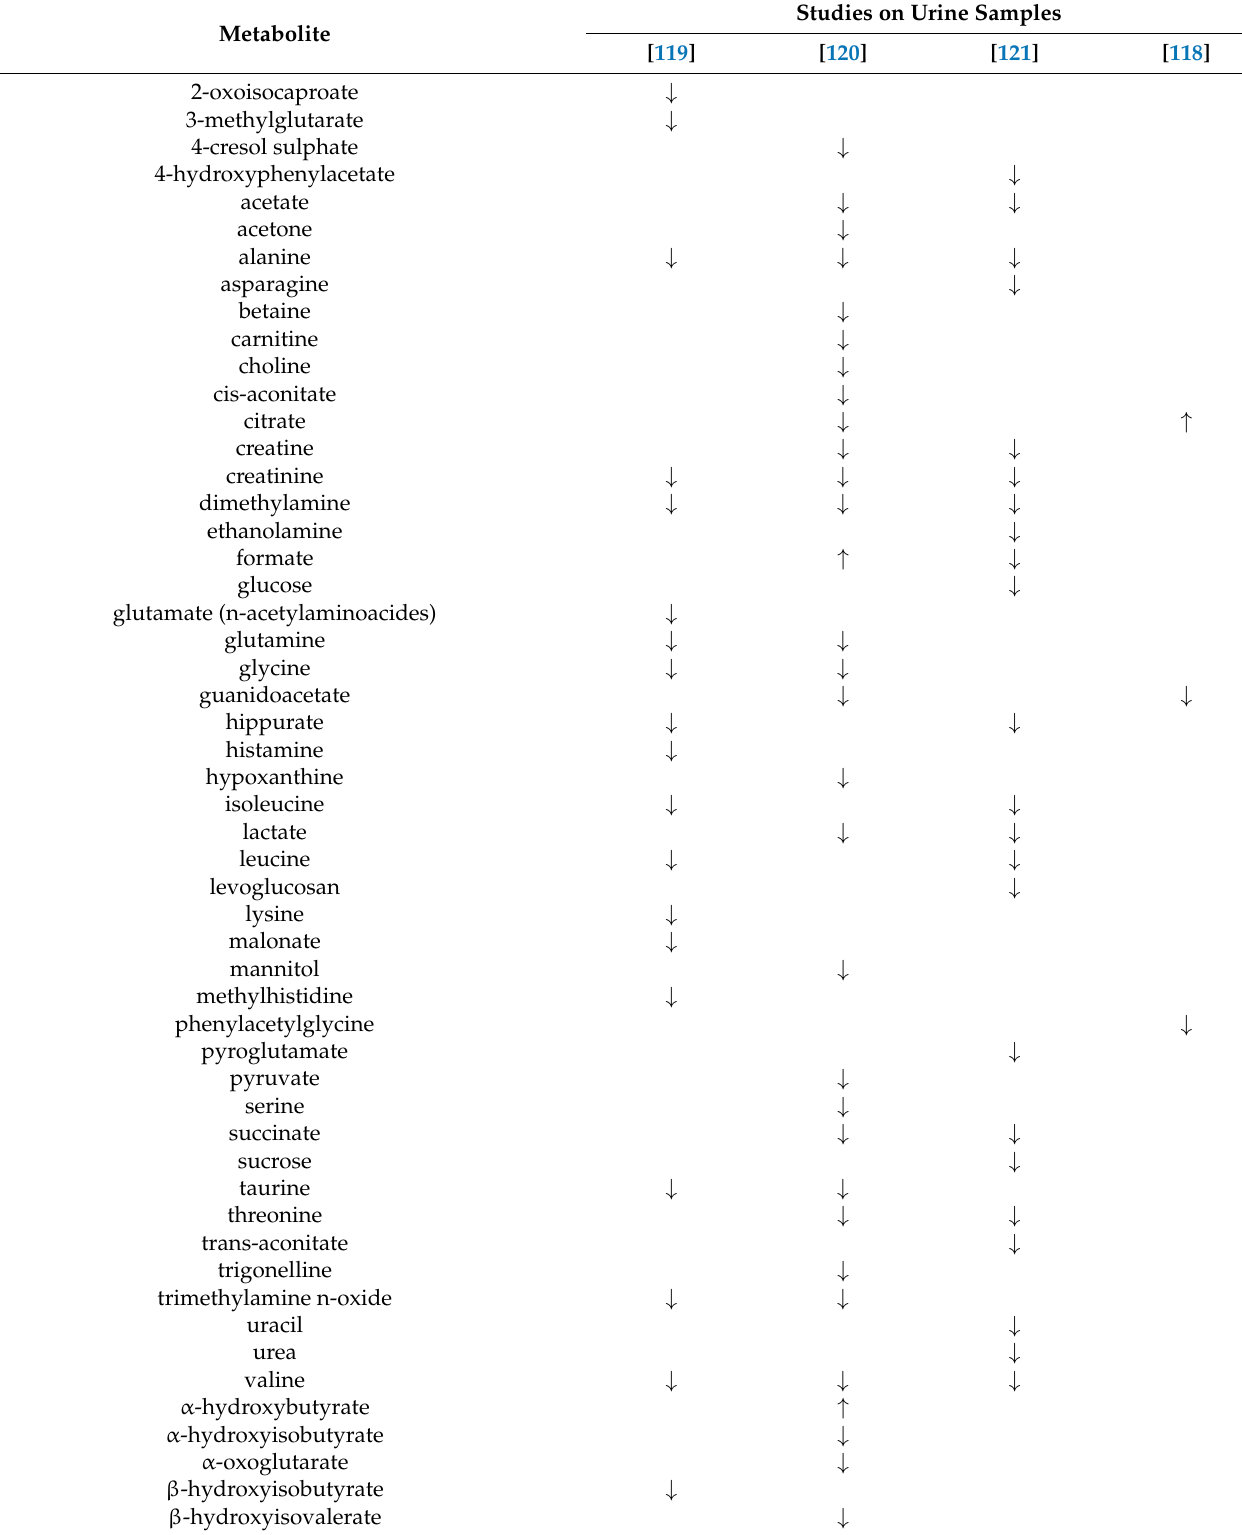
Table 5. List of altered metabolite levels identified in urine samples of BC patients with respect to healthy controls.